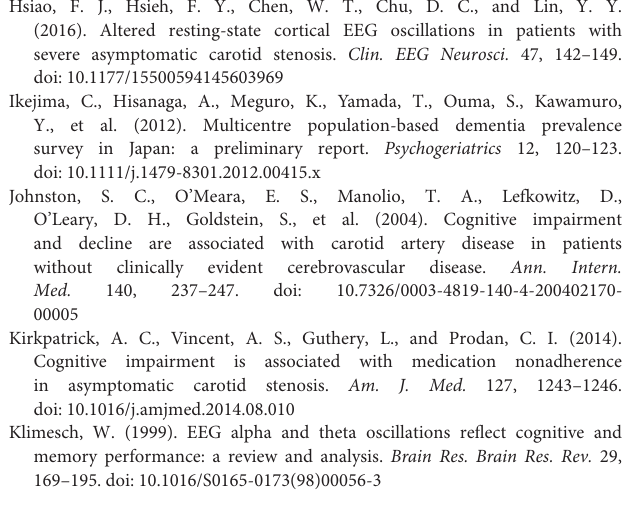
Supplementary Figure1 | Two normalizations for understanding sNAT figuratively. Normalization of sNAT is often likened to a photograph processing. (a) PS, (b) NPS, (c) sNAT corresponds to (d–f) , respectively. (d) means a original subject (e.g., ship) in a frame, (e) means the adjustment of the size to frame the subject, and (f) means that the centroid of the subject is moved to the center of the